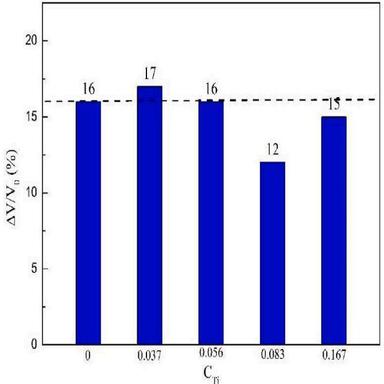
vol change (%) of unit cell at perfect and full desodiated state under Tidoped concentration of 0, 0.037, 0.056, 0.083 and 0.167, respectively.